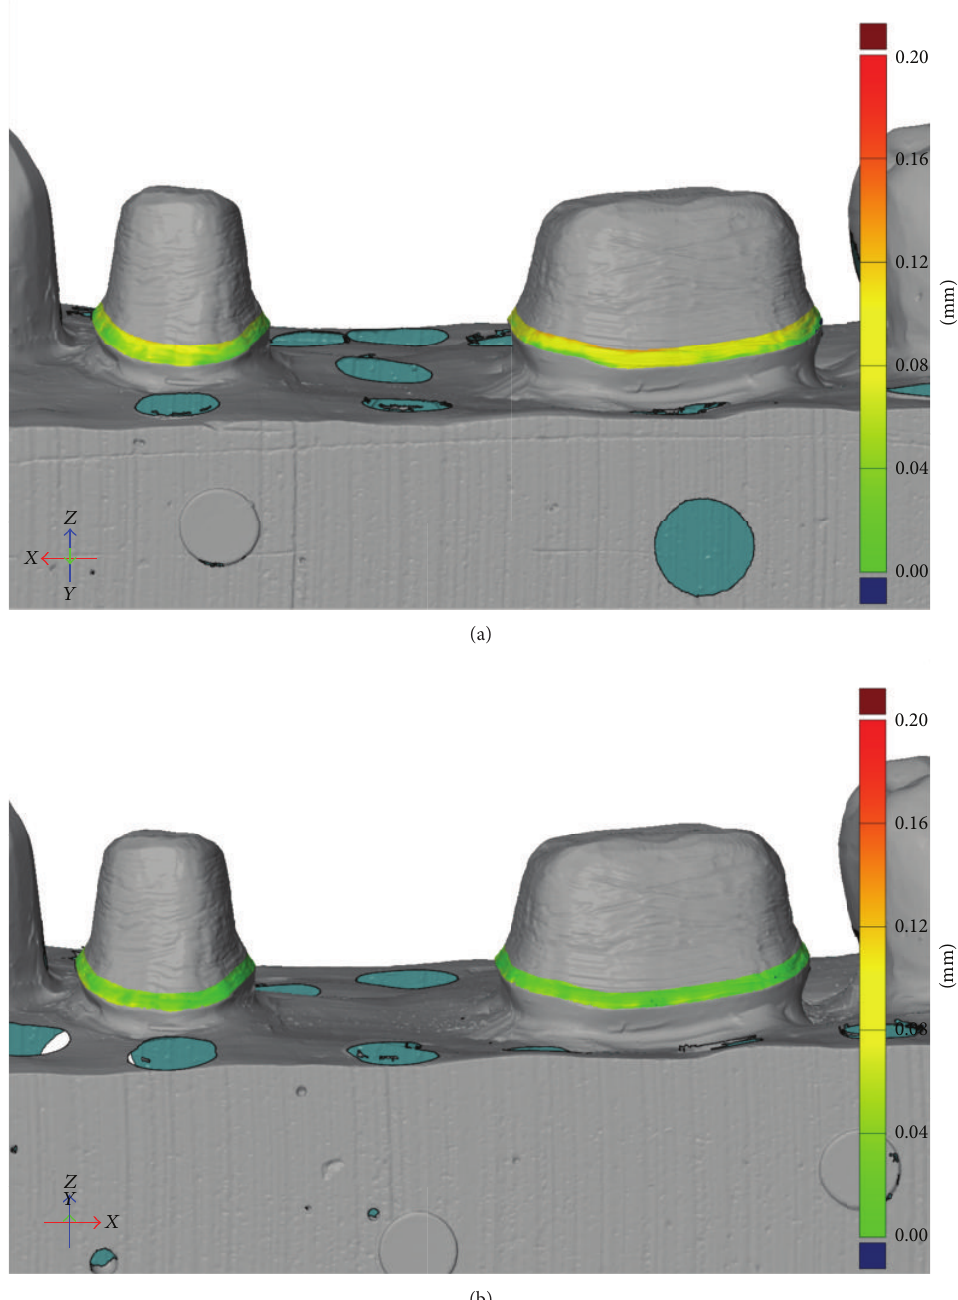
Figure 4: (a) Analysis of the cervical area fit of FDPs produced with the conventional impression technique. The distance from abutment to inside of FDP is represented by color. Green = 0–40 𝜇 m and yellow = 70–110 𝜇 m. (b) Analysis of the cervical area fit of FDPs produced with the digital impression technique. The distance from abutment to inside of FDP is represented by color. Green = 0–40 𝜇 m and yellow = 70–110 𝜇